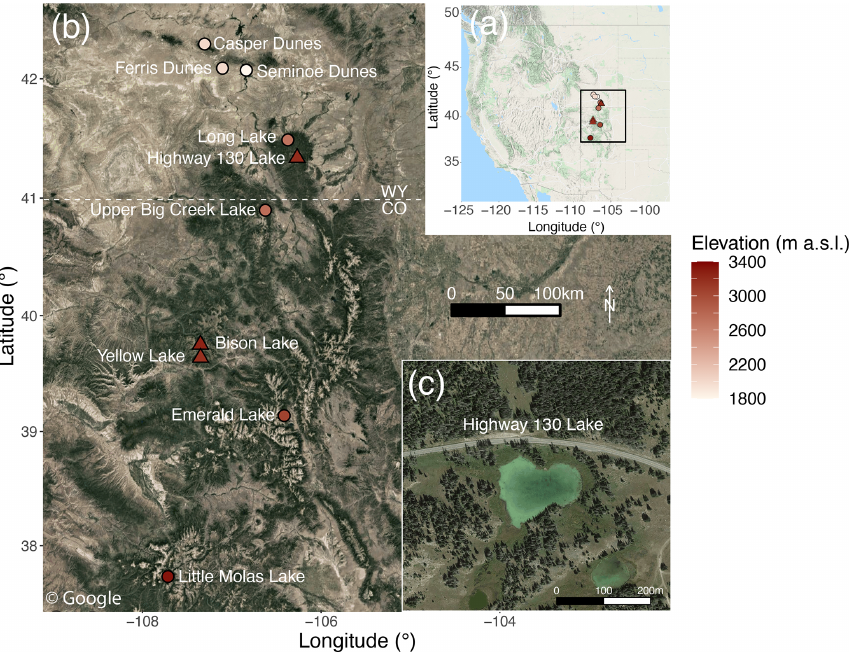
Figure 1. Locations of the study site and related climate records. (a) Highway 130 Lake (triangle; this study) and related carbonate (triangles), dune-field chronology, pollen, and lake-level records (circles) lie within the southern Rocky Mountains, a critical headwater area in the western United States that contributes snowmelt to the Colorado and North Platte rivers. (b) Study site locations in the Colorado Front Range and Medicine Bow Mountains, southeastern Wyoming. (c) Highway 130 Lake lies within the Snowy Range, a subsection of the Medicine Bow Mountains. Google images (© Google Maps 2021) were acquired using the ggmap package in R (Kahle and Wickham,